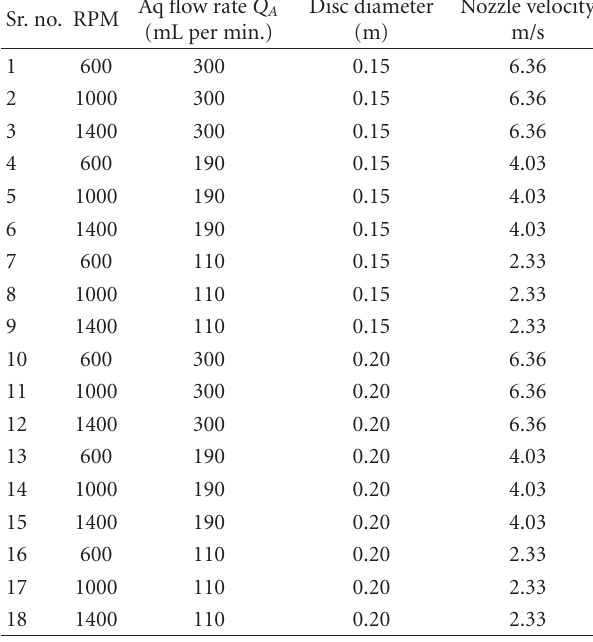
Table 1: Simulation details and results of two-opposed-jet microex- tractor using